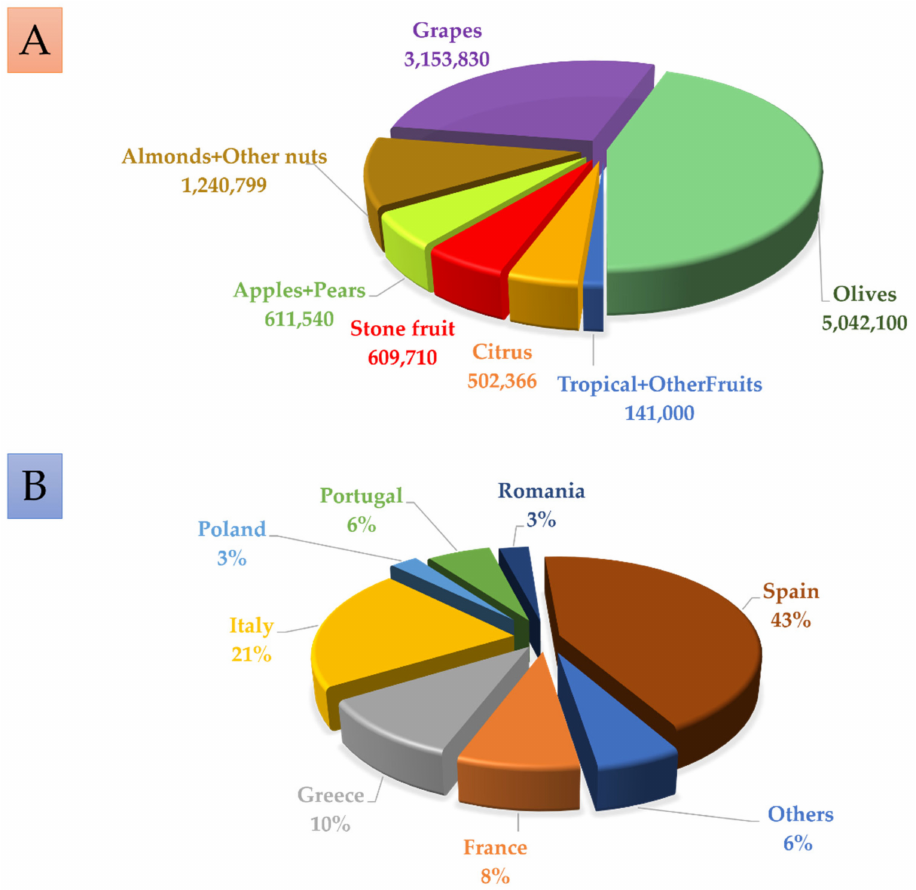
Figure 1. ( A ) Fruit tree area in the EU and ( B ) distribution of fruit trees areas in EU countries ( 1B ) [1]. Regarding the distribution of the fruit growing area in the EU member countries, Spain stands out with 43% of the total surface, followed by Italy with 21%, Greece with 10%, France with 8%, and Portugal with 6% (Figure